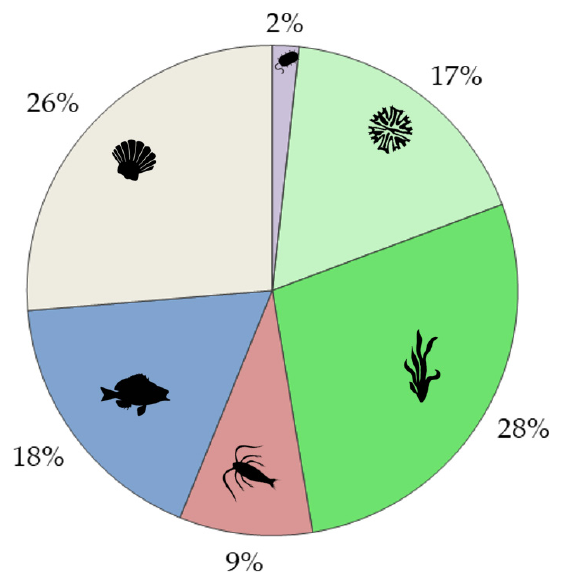
Figure 5. The percentage of organism groups (microorganisms, phytoplankton, macrophytes, zooplankton, fish, and benthos) used in bioaccumulation studies (reviews omitted) based on the bibliometric information on bioaccumulation (see Table 1). 57 organisms were used in the bioaccumulation studies of 45 papers.